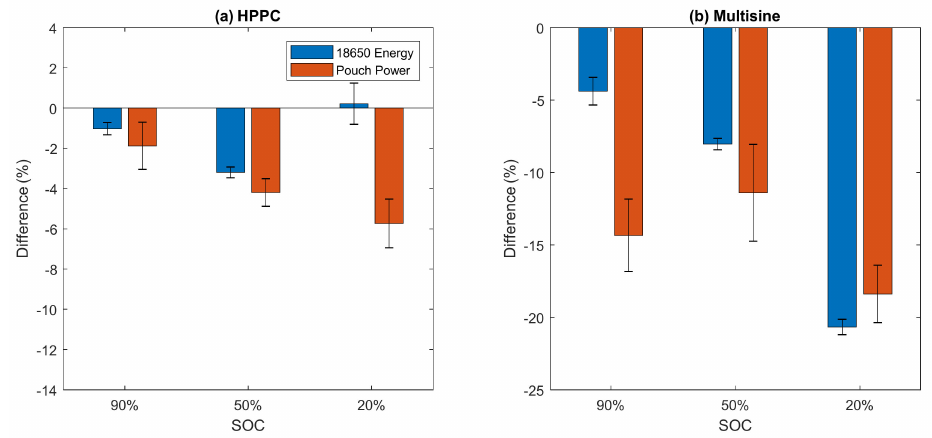
Figure 5. Percentage difference in internal resistance (accelerated minus reference).